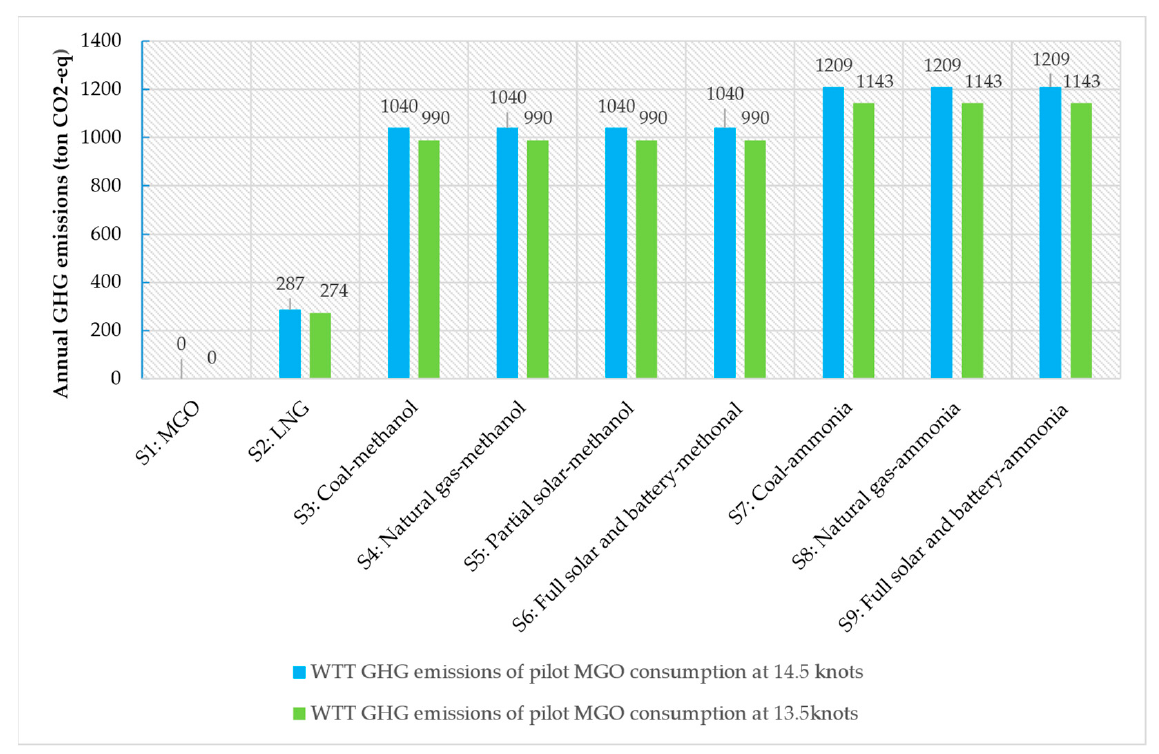
Figure 5. Annual WTT GHG emissions of annual pilot MGO consumption.